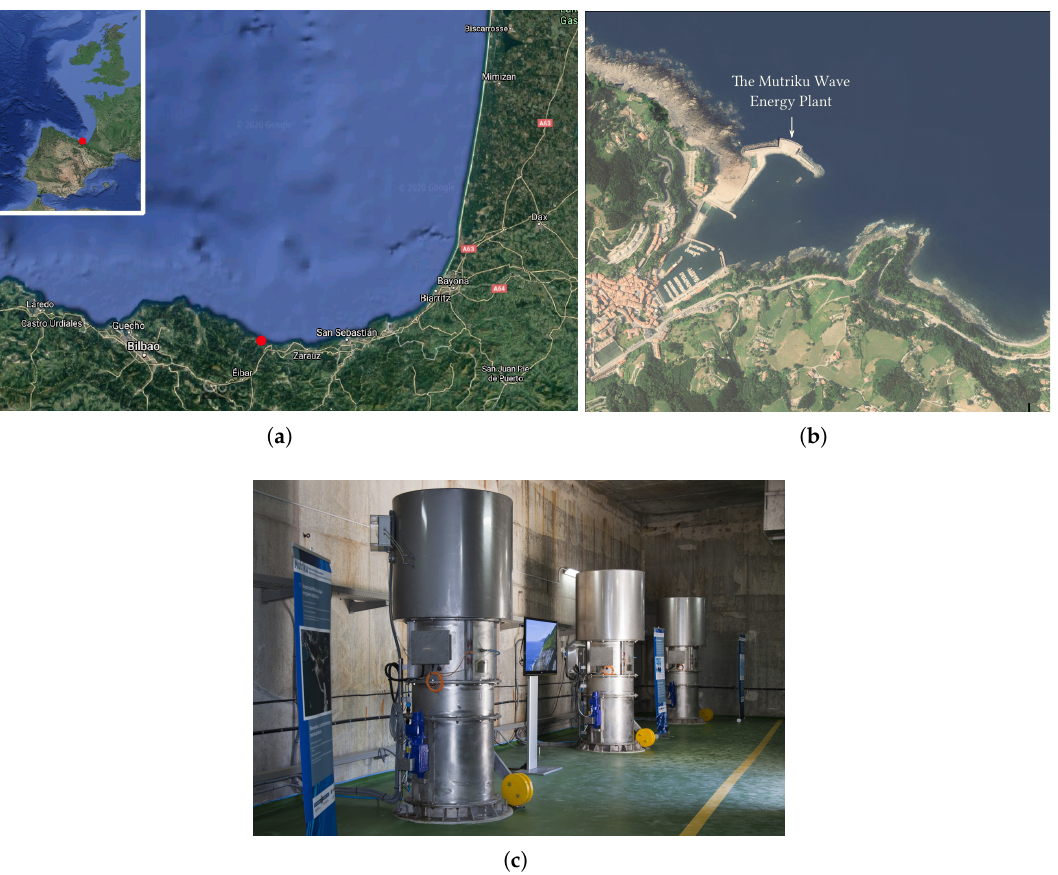
Figure 1. Location and turbo-generators of the MWEP. ( a ) Location of the harbour at Mutriku (source: Google Maps [9]). ( b ) Bird’s eye view of Mutriku harbour and the OWC-breakwater system. (source: geoEuskadi [10]). ( c ) Mutriku Wells Turbo-generators (source: EVE